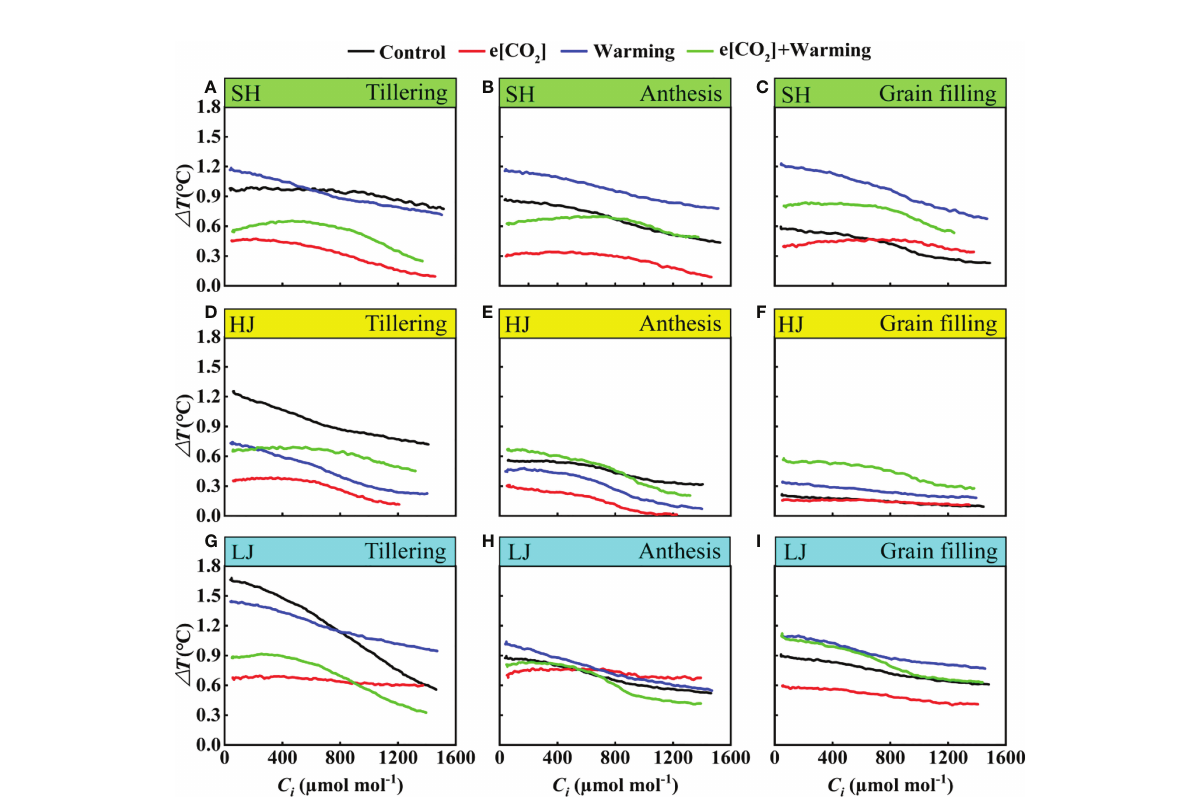
FIGURE 10 The D T - C i Curves under ambient CO 2 and temperature (black dots, Control), elevated [CO 2 ] (red dots, e[CO 2 ]), elevated temperature (blue dots, warming), and e[CO 2 ] plus warming (green dot, e[CO 2 ] +warming) for cv. SH ( A-C ), HJ ( D-F ), and LJ ( G-I ) during the tillering, anthesis, and grain- fi lling stages. D T represents the air-to-leaf temperature difference, C i represents intercellular carbon dioxide